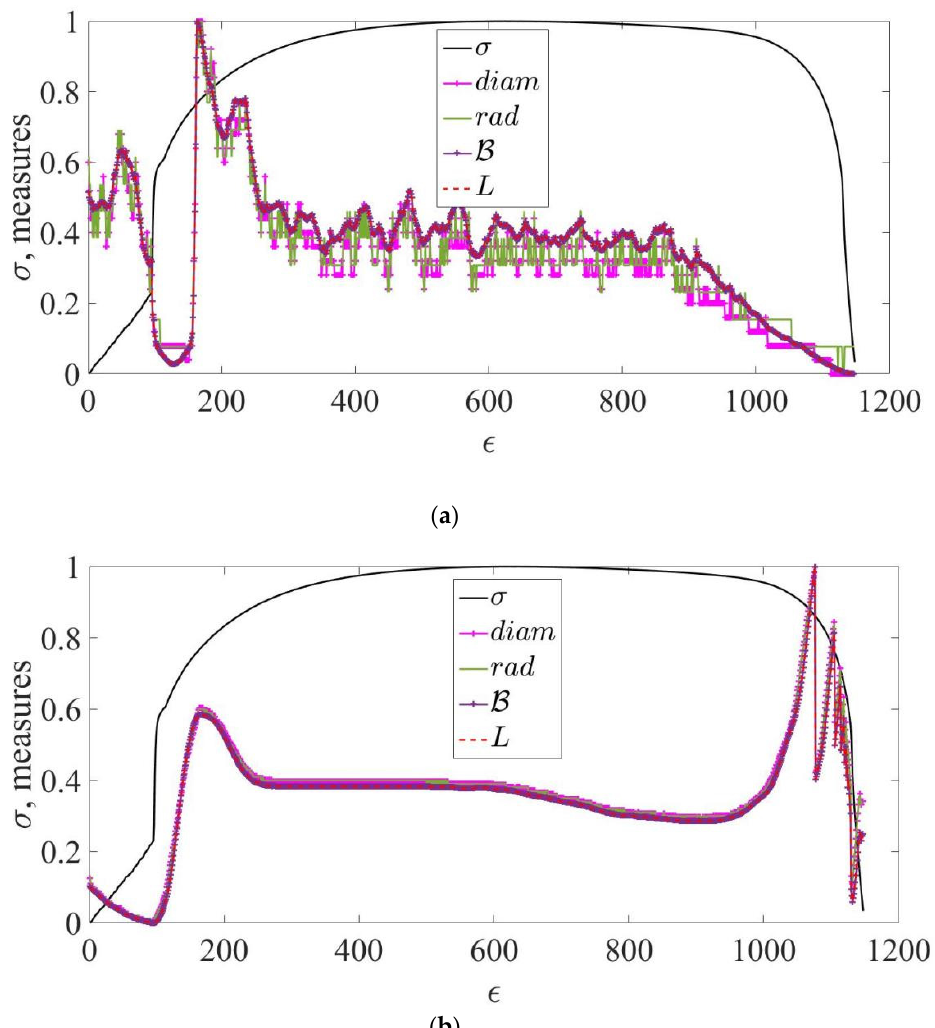
Figure 6. The dynamics of the diameter ( diam ), radius ( rad ), global betweenness centrality ( B ), and average shortest path length ( L ) based on the VG ( a ) and the RP ( b ) approaches for the stress–strain time series.